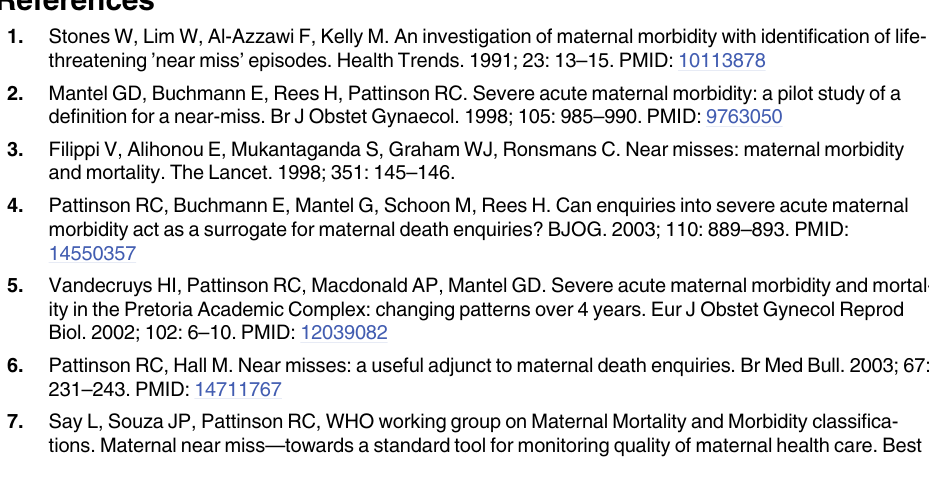
S1 Fig. Differences in MNM inclusion based on threshold for blood transfusion.